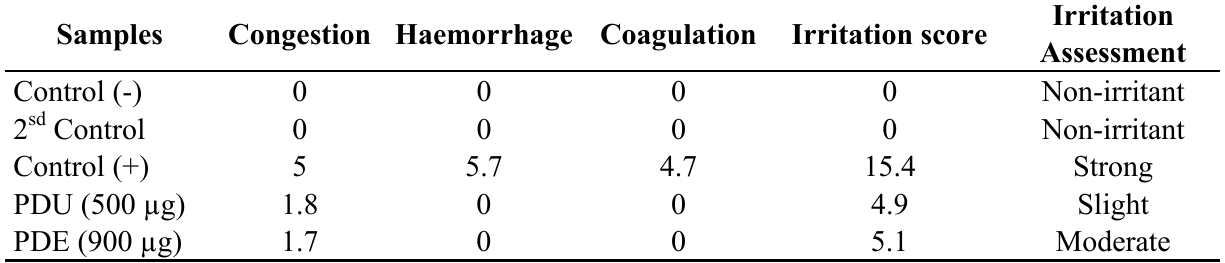
Irritation Assessment